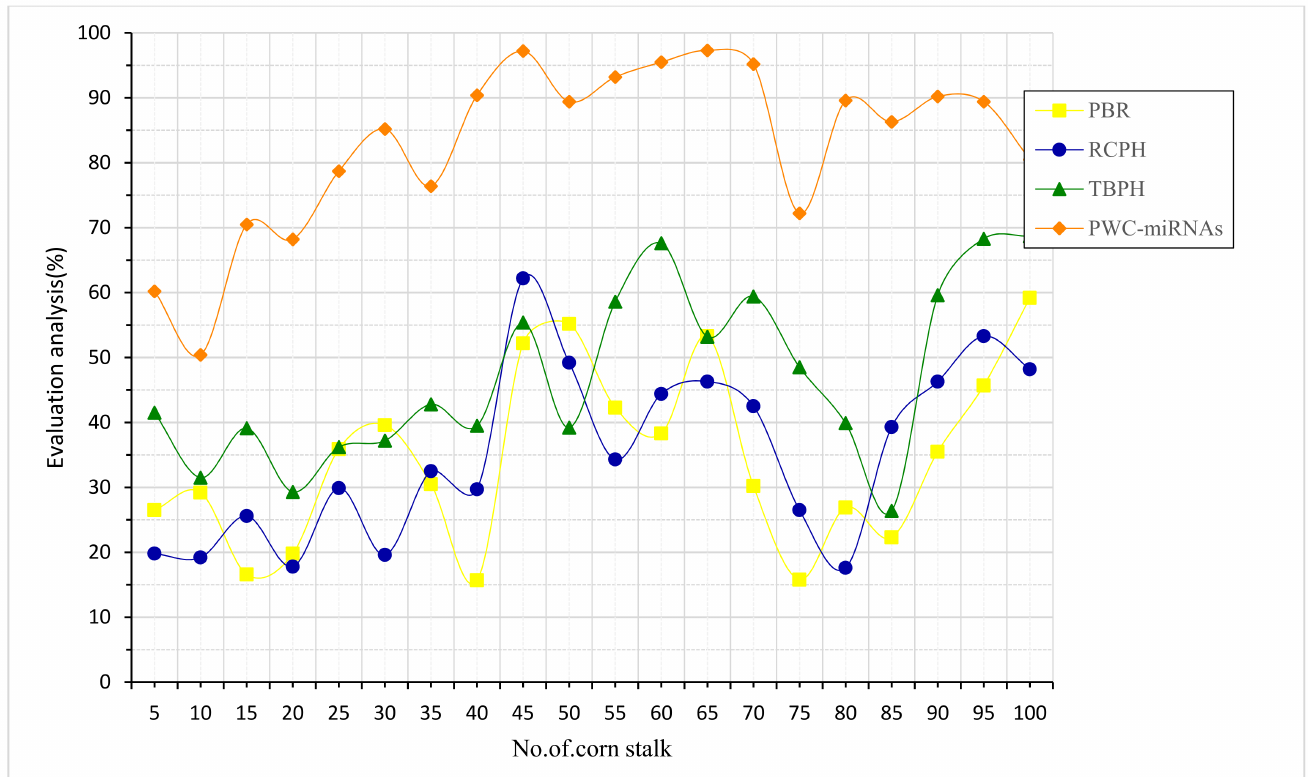
Figure 7. Evaluation analysis for corn stalk based on